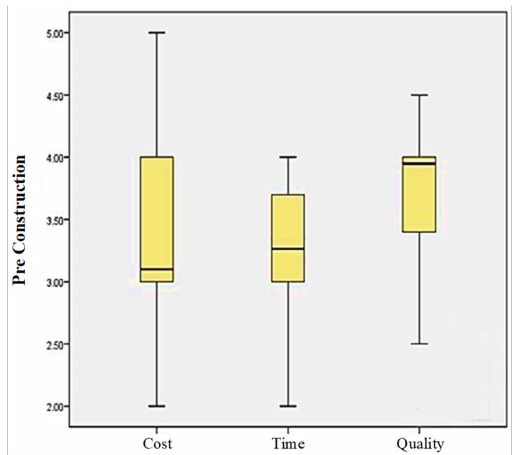
Figure 2. Comparison of changes in indicators (cost, time, quality) in the pre-construction stage.